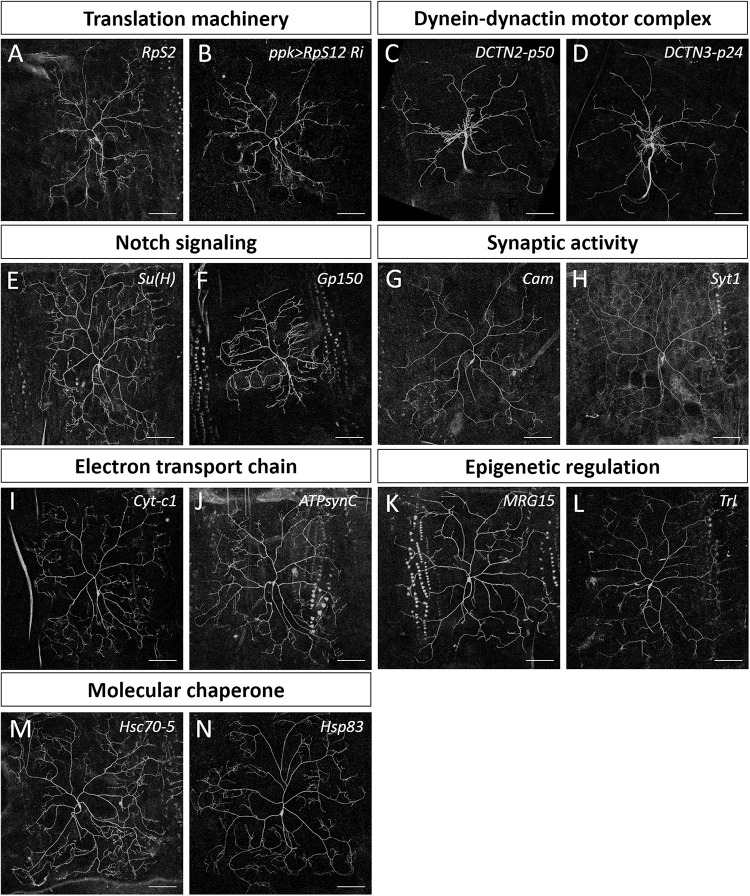
Dendrite regulators in conserved complexes or pathways. (A,C–N) Representative c4da MARCM clones for indicated mutants with alleles RpS2k01215
(A), DCTN2-p50k16109
(C), DCTN3-p24k14618
(D), Su(H)k07904
(E), Gp150k11120
(F), Camk04213
(G), Syt1k05909
(H), Cyt-c1KG05986
(I), ATPsynCKG01914
(J), MRG15j6A3
(K), Trls2325
(L), Hsc70-5k04907
(M), and Hsp83j5C2
(N). (B) The mCD8::GFP-labeled dendrite of a c4da neuron with RpS12-RNAi knockdown by ppk-GAL4. Scale bars = 100 μm.